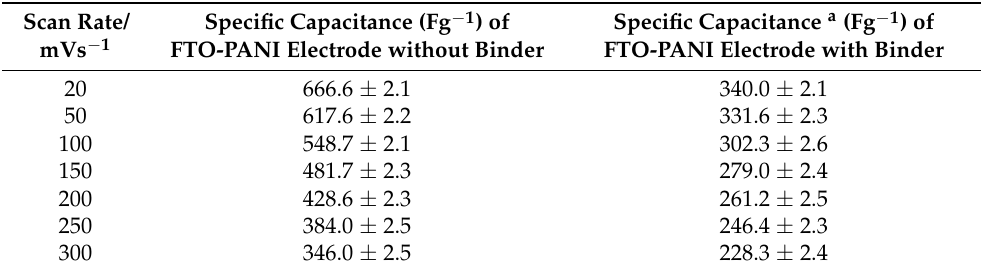
Table 1. Specific capacitances (C sp ) values of binder free and binder supported FTO-PANI electrode with binder at wide range scan